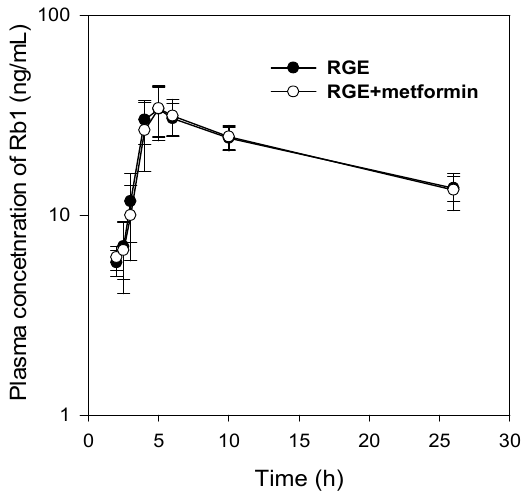
Figure 2. Plasma concentration–time profile of ginsenoside Rb1 following a single oral dose of RGE (2 g/kg) in the absence or presence of metformin (50 mg/kg) in streptozotocin (STZ)-induced diabetic rats. Data points are means ± SD of five rats. Table 2. Plasma concentration-time profile of ginsenoside Rb1 following a single oral dose (2 g/kg) of red ginseng extract (RGE)in the absence or presence of metformin (50 mg/kg) in streptozotocin (STZ)-induced diabetic rats.